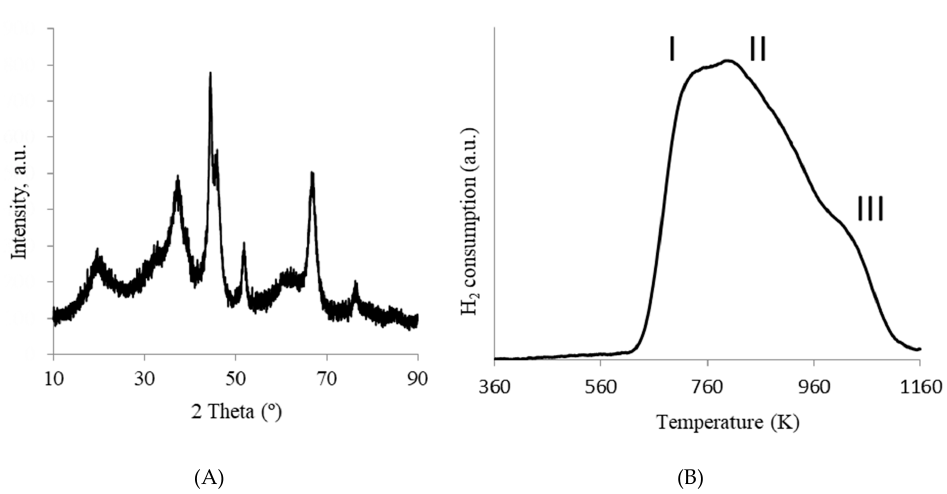
Figure 3. X-ray diffraction pattern ( A ) and TPR profile of 10%Ni-1.5CrA/Al 2 O 3 sample ( B ). Figure 3. X-ray di ff raction pattern ( A ) and TPR profile of 10%Ni-1.5CrA / Al 2 O 3 sample ( B ). Therefore, 10%Ni-1.5Cr СО /Al 2 O 3 catalyst contains more than 85 % of surface nickel, and ultrahigh dispersive chromium particles being included between nickel nanoparticles (size of 2–10